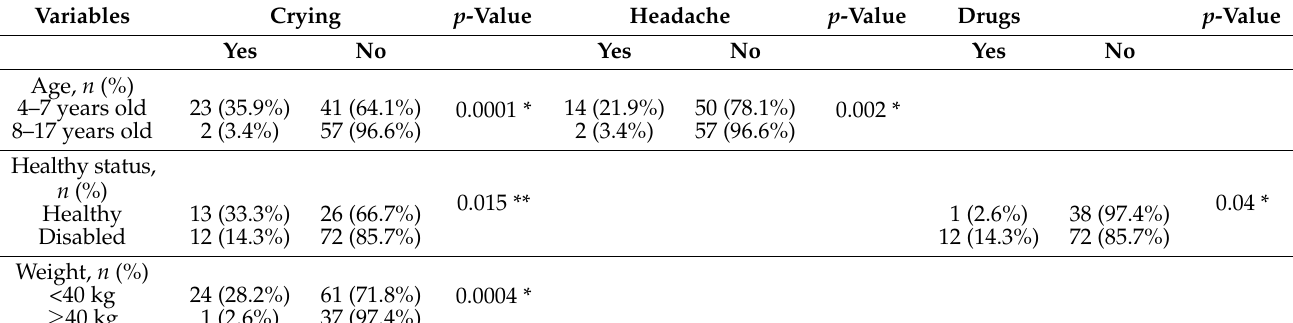
Table 3. Statistical analysis of post-discharge effects and patient’s